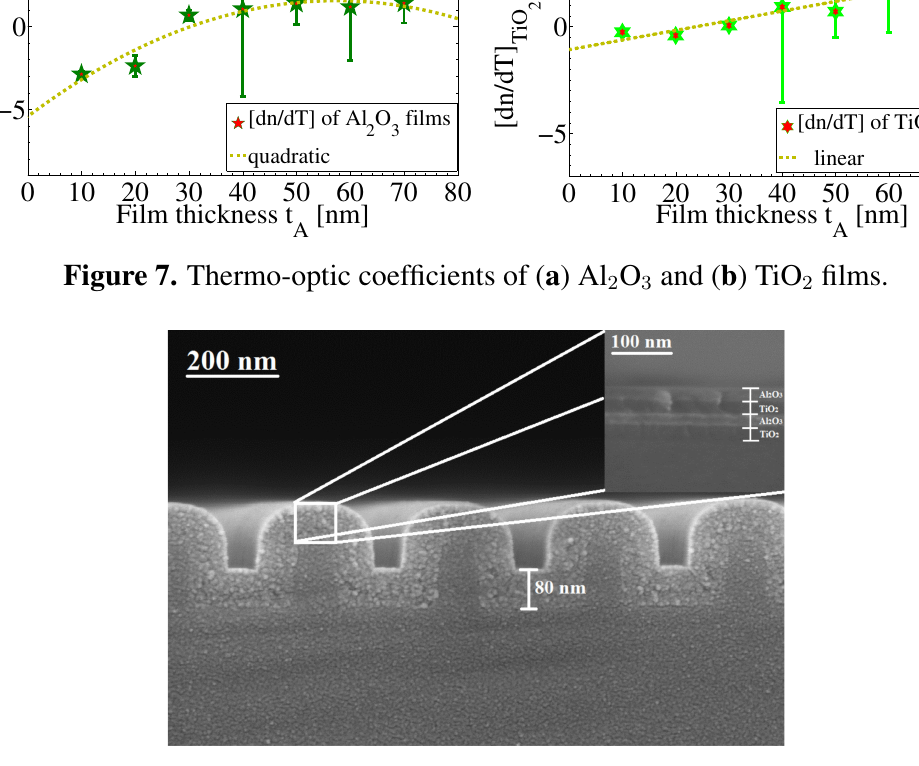
–Al O bilayer 2 2 3